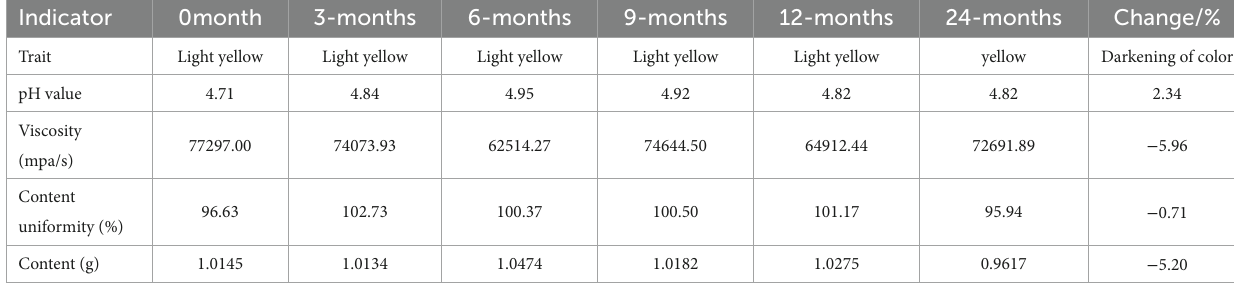
TABLE 1 Changes in the long-term stability of chloroquine phosphate gel from 0 to 24